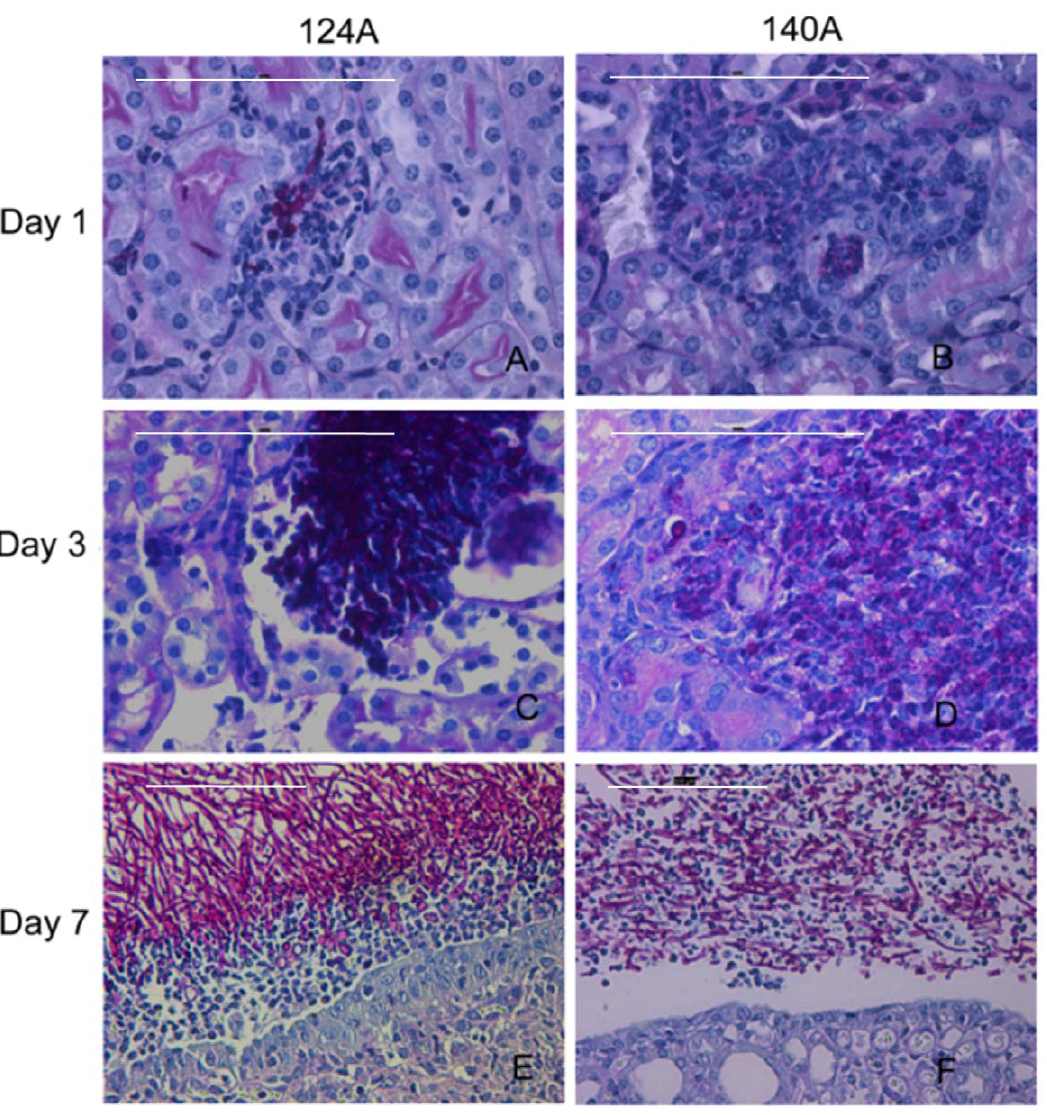
Figure 4. Kidney histology. Representative micrographs of H&E/PAS-stained paraffin sections of kidneys recovered from mice infected with 10 6 yeast cells at days 1 (A and B), 3 (C and D) and 7 (E and F) days post-infection with isolates 124A and 140A.The bar 2 100 m M.